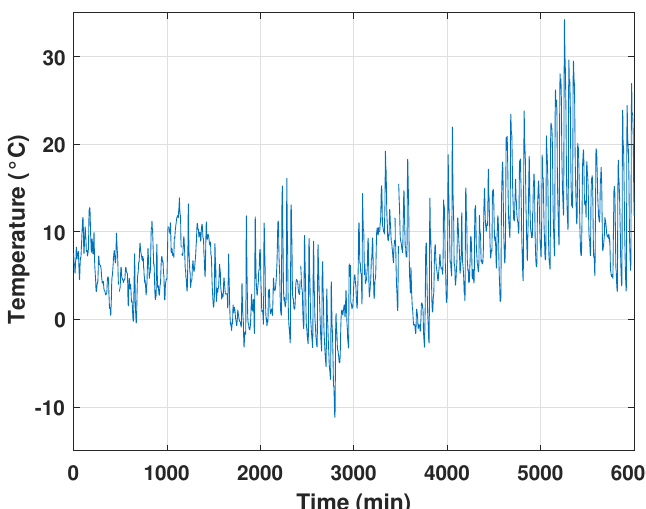
Figure 2. Overview of the room noise set points.